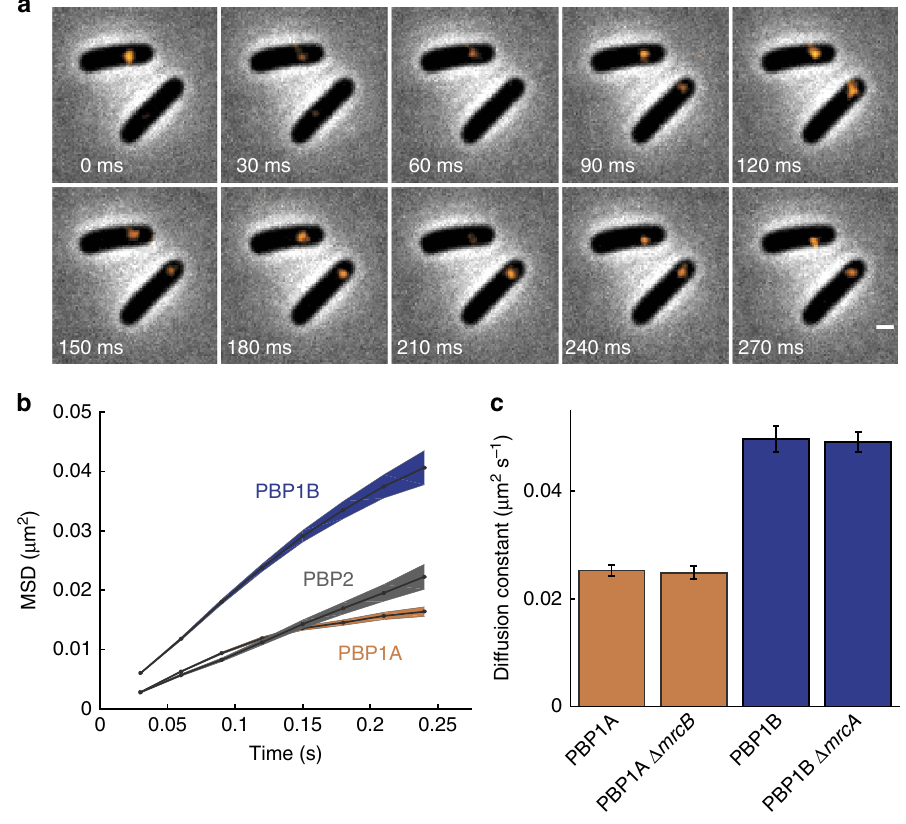
Figure 1 | PBP1A and PBP1B diffuse at different rates. ( a ) TIRF images of PAmCherry-PBP1A molecules (orange) imaged every 30ms in live E. coli (TKL241) at 30 (cid:2) C overlaid on phase-contrast images. Scale bar: 1 m m. ( b ) MSD of PBP1A ( n ¼ 3,177 molecules, TKL241), PBP1B ( n ¼ 898 molecules, TKL211), and PBP2 ( n ¼ 716 molecules, TKL130) fused to PAmCherry. Shaded area represents s.e.m. ( c ) Apparent diffusion constants calculated from a linear fit to the MSD for PBP1A in wild-type ( n ¼ 3,177 molecules, TKL241) and D mrcB (lacking PBP1B; n ¼ 1,994 molecules, TKL240) backgrounds and for PBP1B in wild-type ( n ¼ 898 molecules, TKL211) and D mrcA (lacking PBP1A; n ¼ 1,491 molecules, TKL239) backgrounds. Error bars indicate the s.d. of 1,000 bootstrap